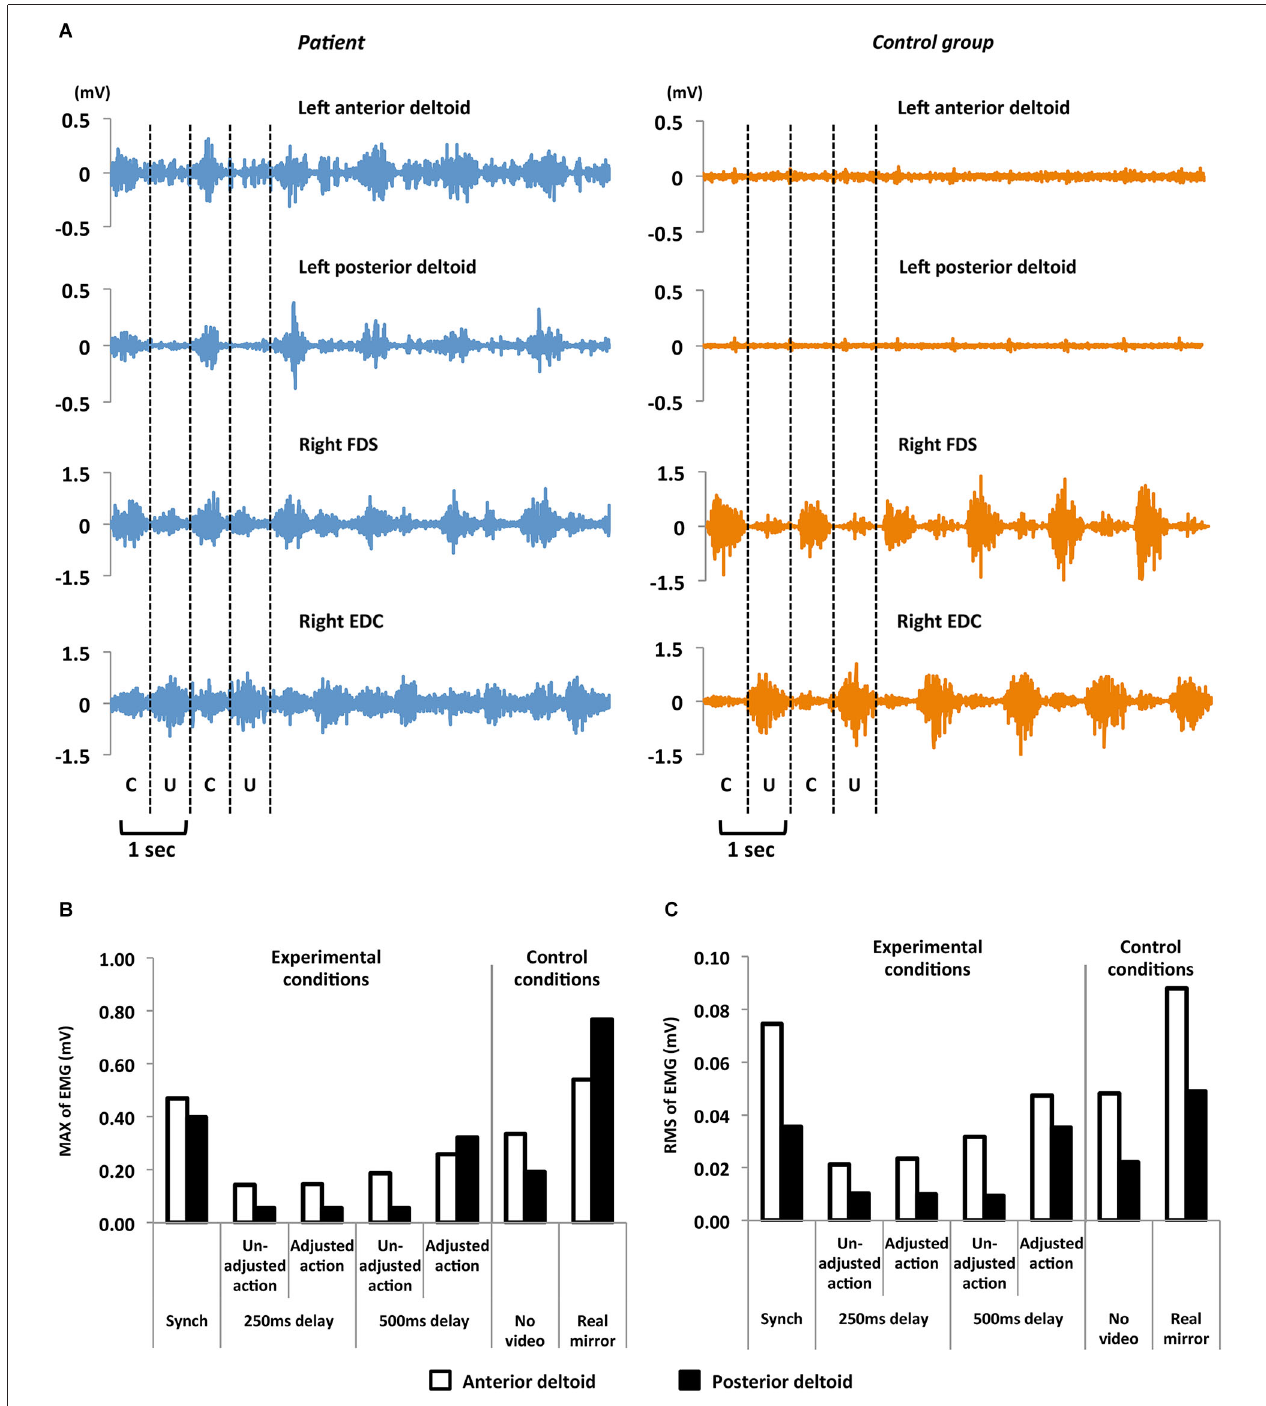
(U). (B) MAX of EMG activity recorded at the patient’s anterior and posterior deltoid as a function of condition. (C) RMS of EMG activity recorded at the patient’s anterior and posterior deltoid as a function of condition. The ratings significantly and positively correlated with each MAX and RMS at both the anterior and posterior deltoid ( r ≥ 0.87, p <